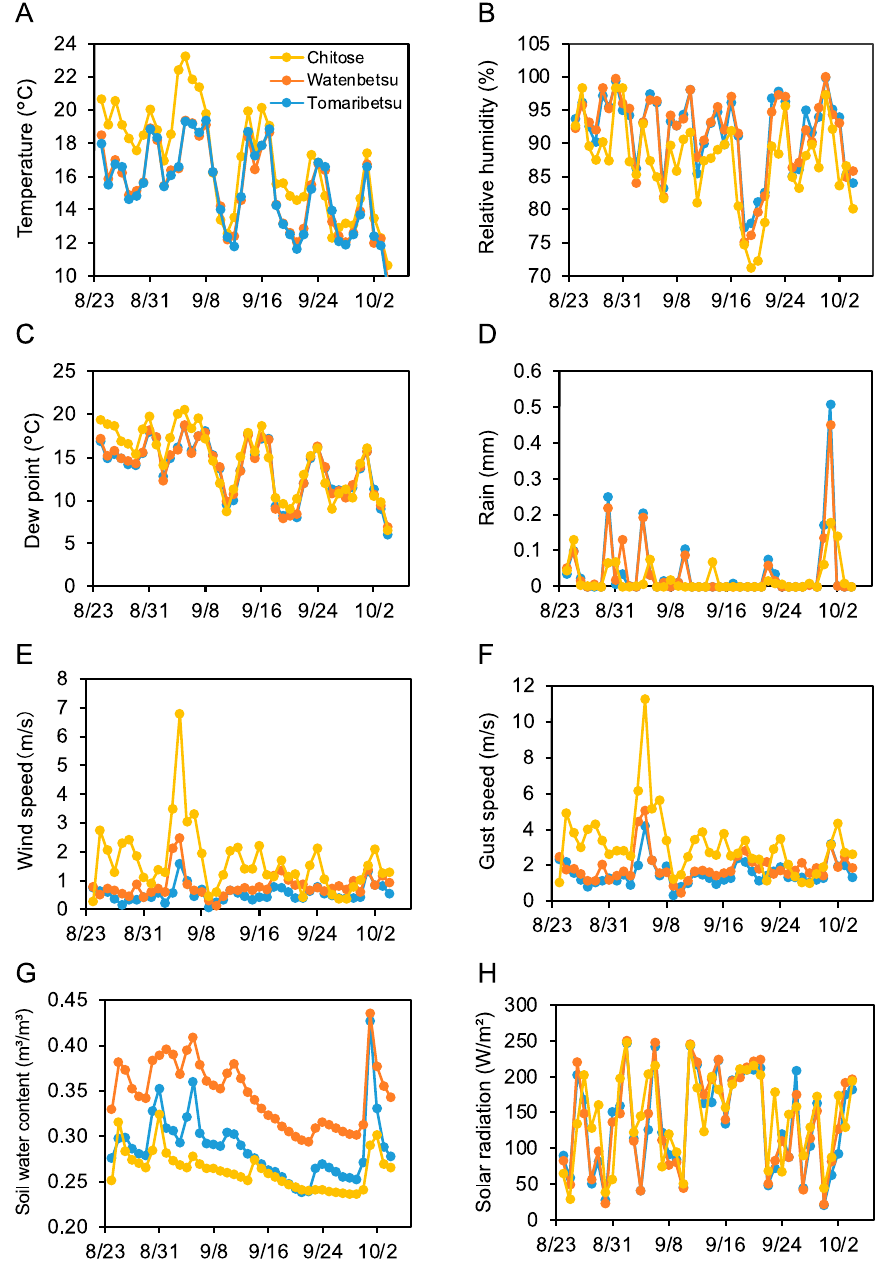
Figure 4. Wind speed and soil water content correlate with regional differences in A β aggregation inhibition activity. Meteorological data was measured in three fields from August 24 to October 4, shown as daily averages. Yellow, red, and blue show Chitose, Watenbetsu, and Tomaribetsu, respectively. Temperature ( A ), relative humidity ( B ), dew point ( C ), rain ( D ), wind speed ( E ), gust speed ( F ), soil water content ( G ), and solar radiation ( H ). Data represent an average of each day from every 10 min measurement. 3.3. A β Aggregation Inhibitory Activity of Perilla frutescens var. crispa Was Highest just before Flowering and Was Enhanced by the Wind